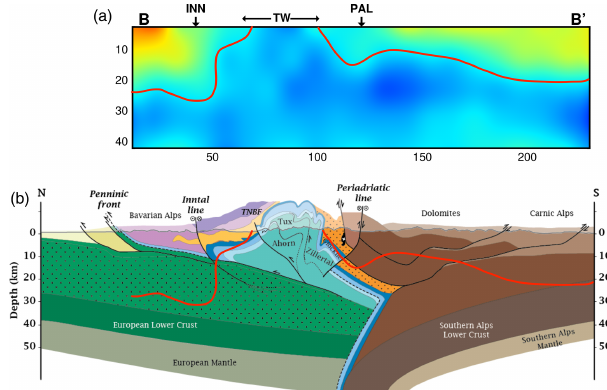
Figure 15. (a) Cross section of the RVs model along the TRANSALP profile. (b) Section showing geological interpretation of the TRANSALP in the surface location of the Tauern (Schmid et al., 2004; Bousquet et al., 2012). The red line in the Tauern Window area separates the high-velocity zone associated with the sub-Tauern basement from lower-velocity crustal rocks. South of this area, the line crosses nappe contacts in the Southern Alps. The Tauern Window (TW), Periadriatic fault (PAL), and Inntal line (INN) are shown on the